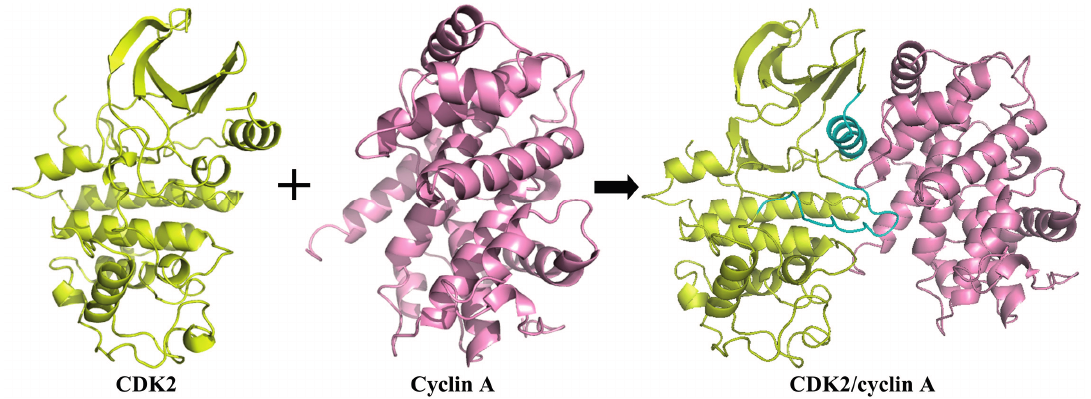
Figure 8. Formation of the CDK2/cyclin heterodimer. The cyan fragments are regions undergoing structural changes upon association with the cyclin subunit. Coordinates used for CDK2 and CDK2/cyclin A are 1HLC and 1OL1,